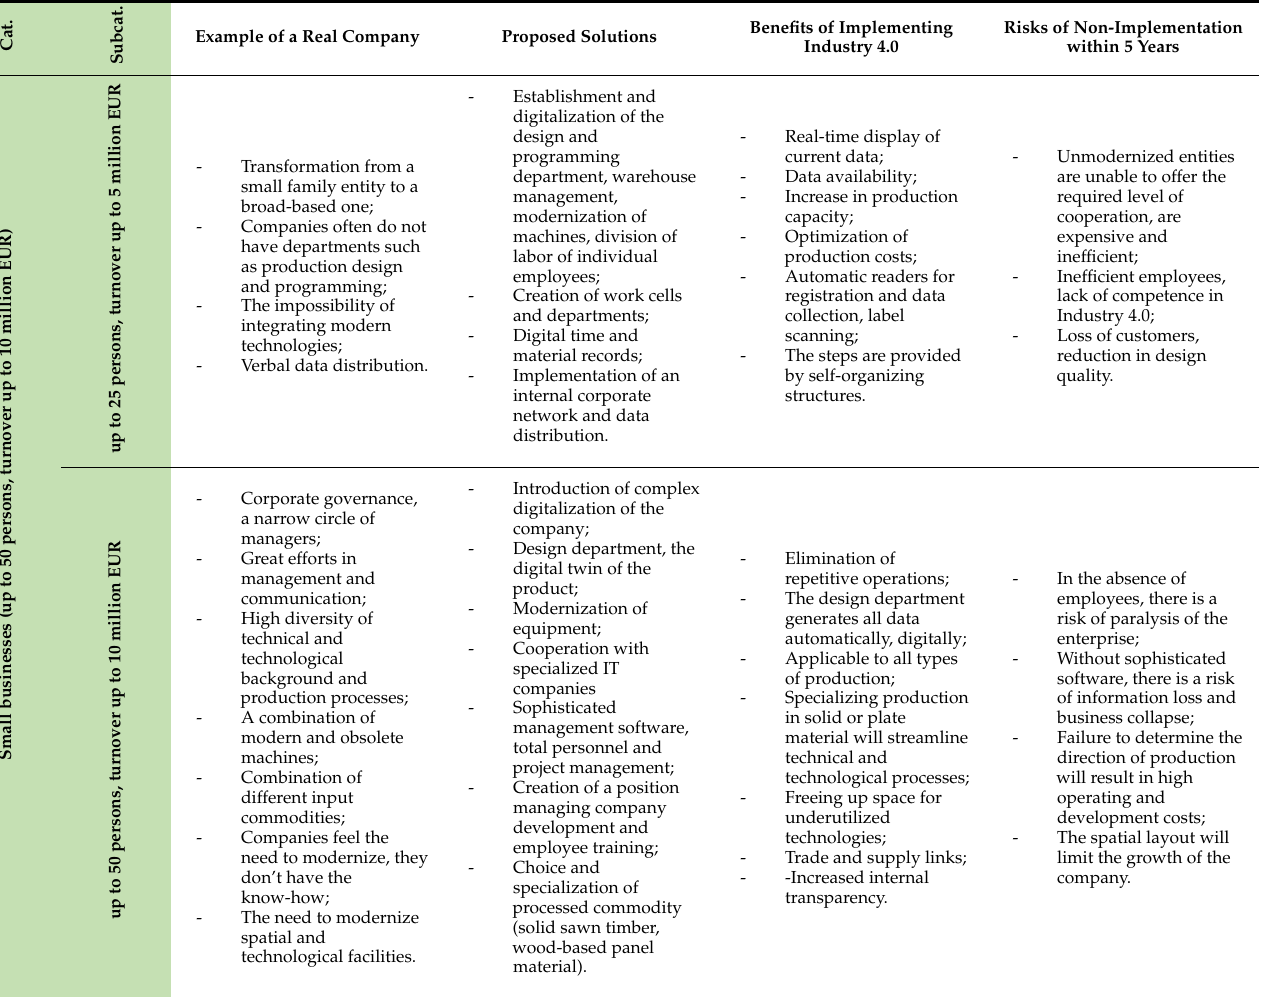
Table 5. Main results and recommendations (scored) for small businesses and the subcategories ( n =